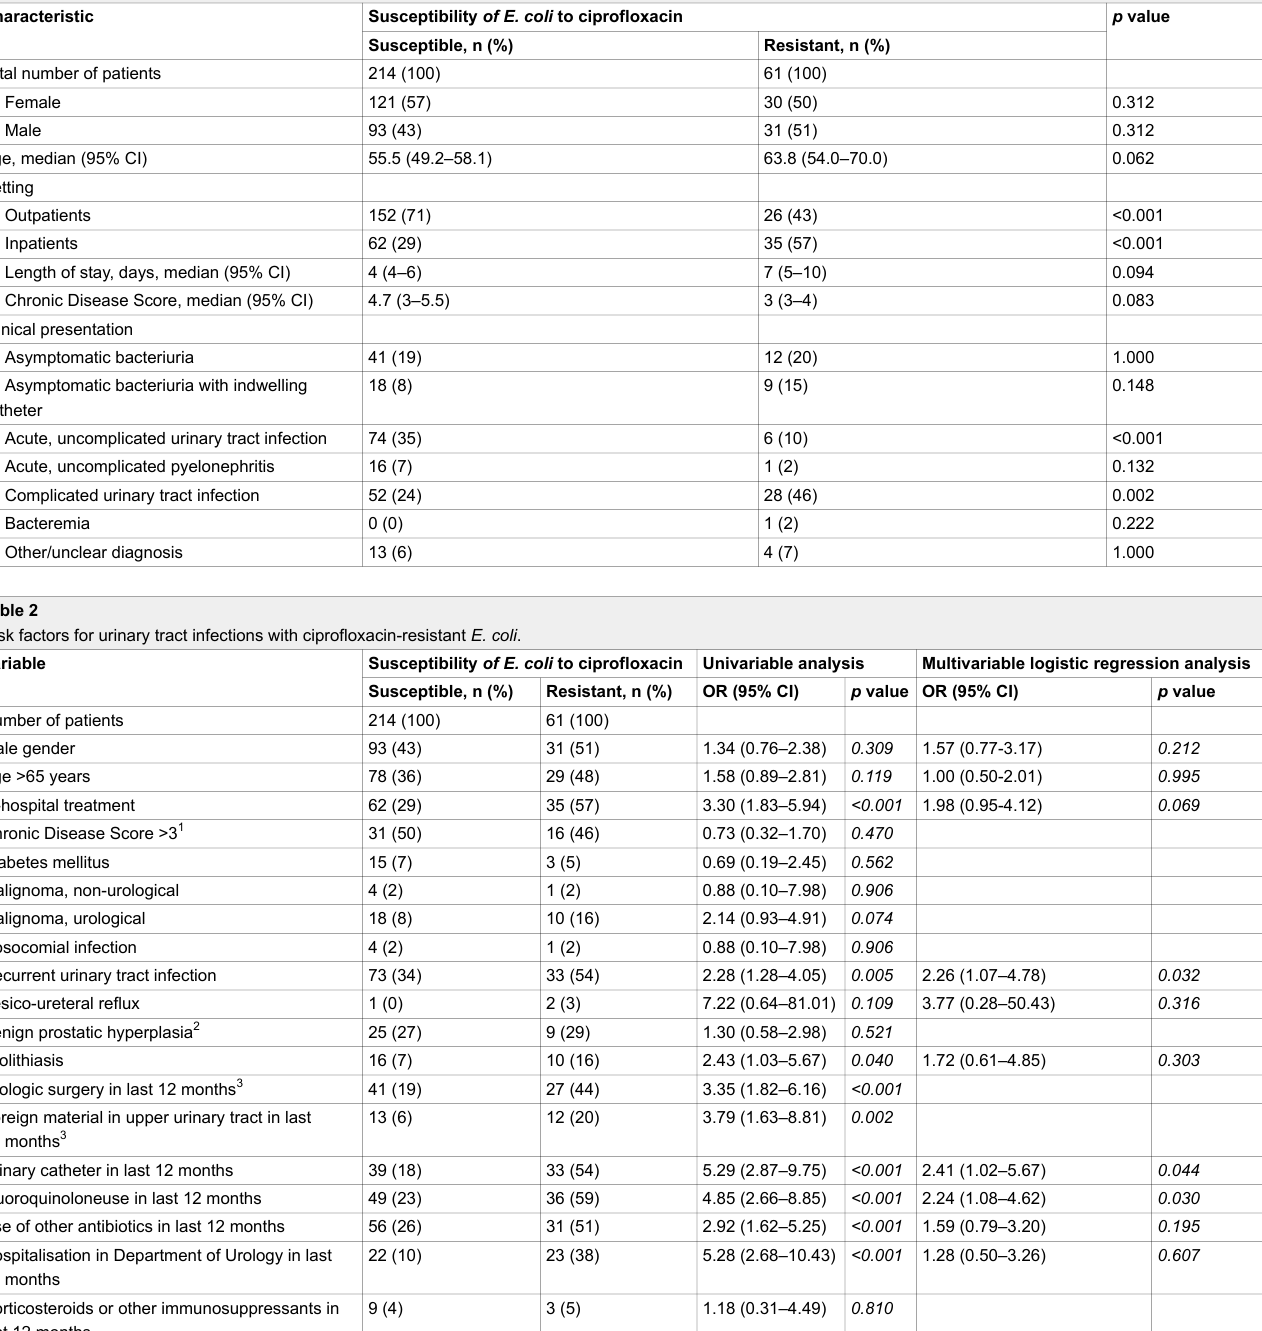
Table 1 Patient characteristics.